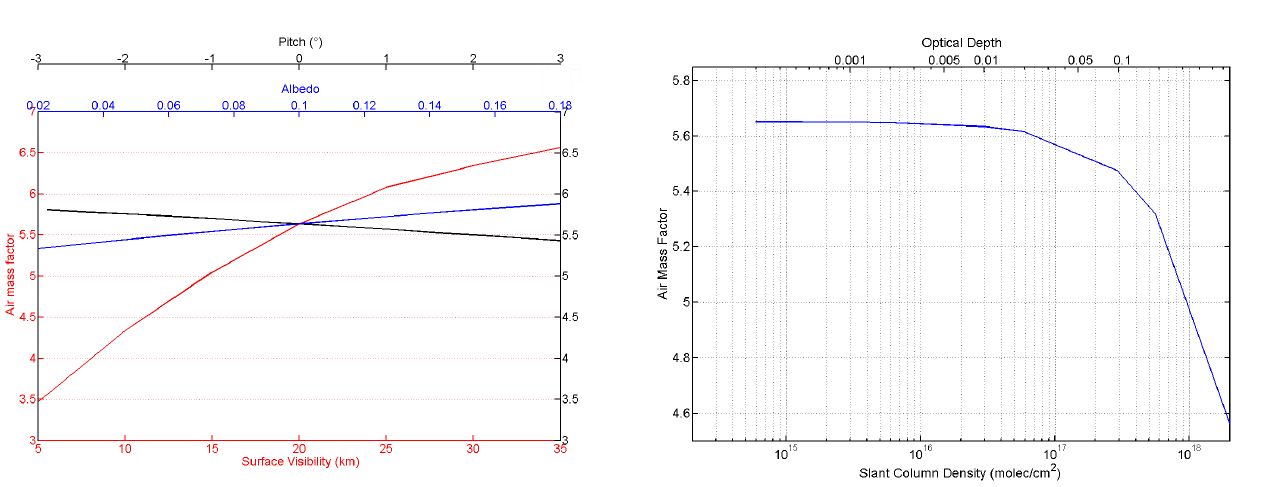
Fig. 8. Air mass factor versus slant column density. NO 2 load- ing starts to influence significantly the radiative transfer above 5 × 10 16 molec cm − 2 . The calculations were done at 460nm for an altitude of 0.5km, setting a relative azimuth and solar zenith angle of 90 ◦ and 45 ◦ , respectively, and with a 1km thick homogeneous boundary